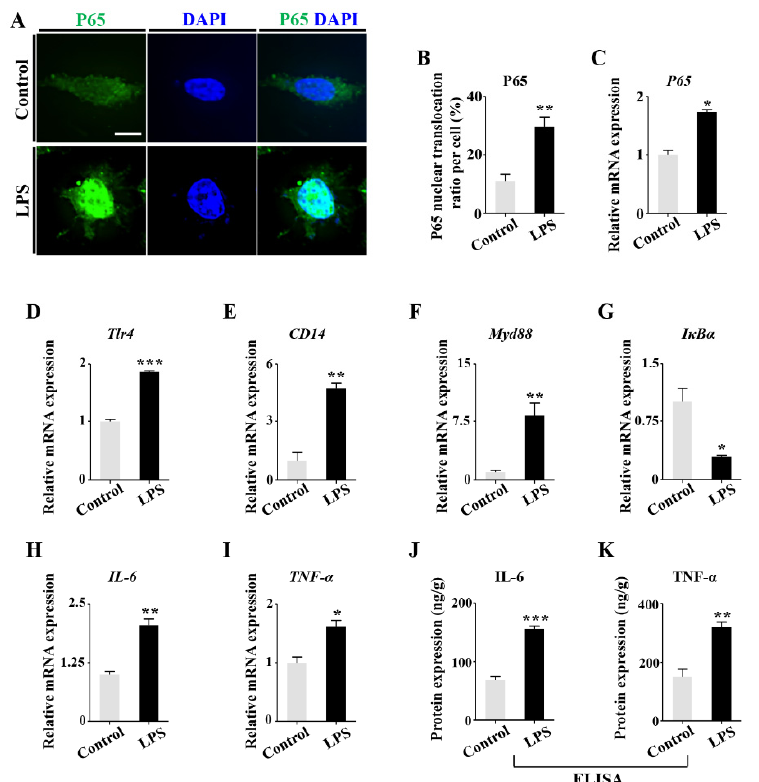
Figure 9. Determining the expression of the inflammatory factors following LPS treatment. ( A ) Representative images of P65 immunofluorescent staining on control and LPS-treated MC3T3-E1 cells, counterstained with DAPI. Negative controls were shown in supplementary material (Figure S7). ( B ) Bar chart comparing the P65 nuclear translocation ratios (percentage) in every cell between control and LPS-treated group. ( C – I ) qPCR showing the expressions of P65 , Tlr4 , CD14 , Myd88 , IL-6 , and TNF- α genes at mRNA level of control and LPS-treated MC3T3-E1 cells. ( J , K ) ELISA assay showing the protein expression of IL-6 and TNF- α . Units represent measured protein normalized to total protein. Scale bars = 10 μ m in ( A ). (* p < 0.05, ** p < 0.01, *** p < 0.001).